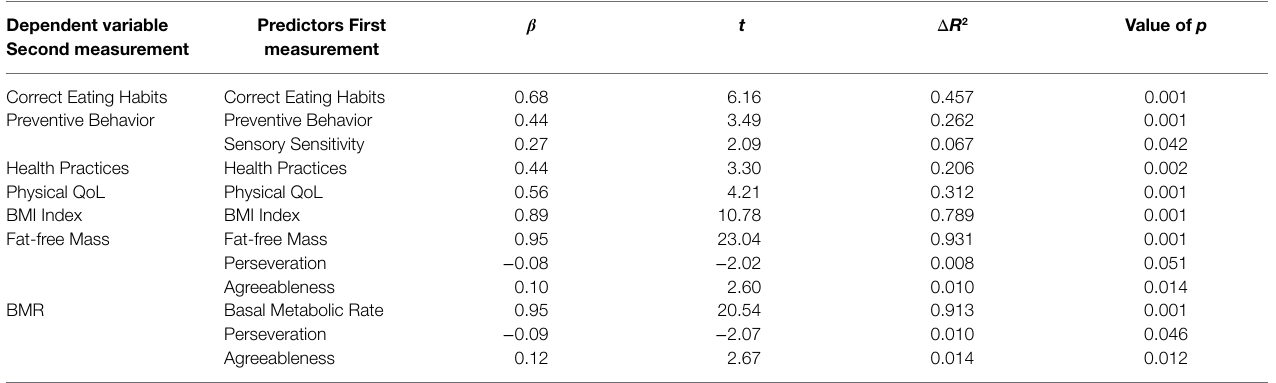
TABLE 3 | Temperamental and personality traits analyzed as predictors of health indicators in the second measurement. Dependent variable Second measurement